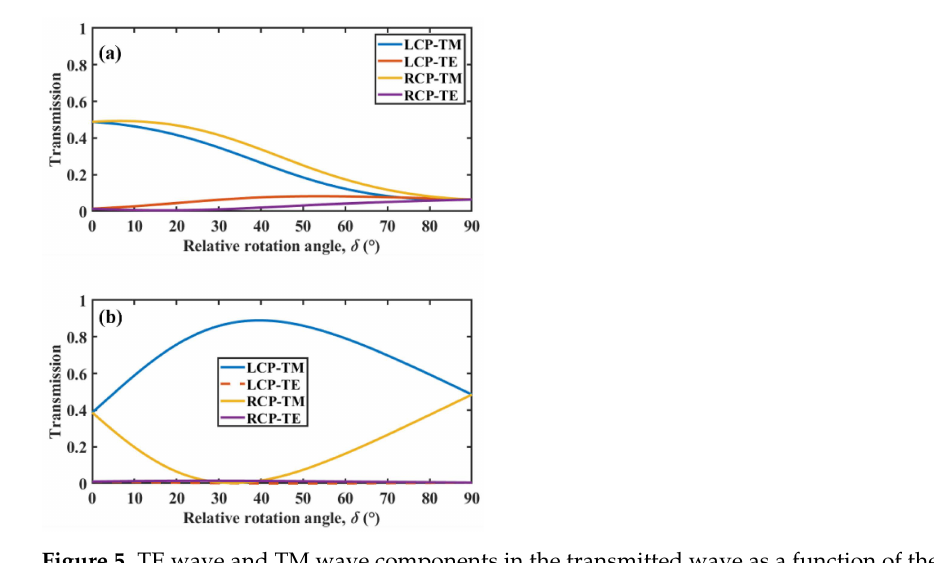
Figure 4. Maximum value of CD as a function of the rotation angle under different f when the wavelength was ( a ) 12 µ m and ( b ) 11 µ m, respectively.